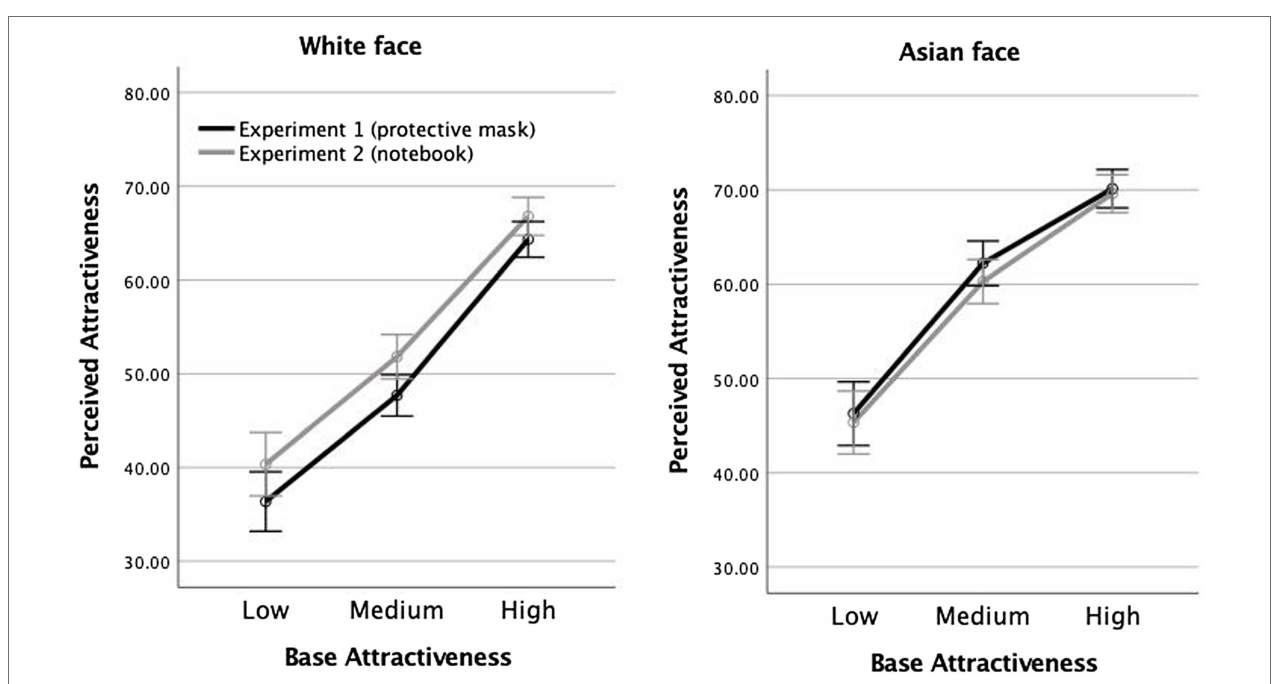
FIGURE 5 | Perceived attractiveness for faces without any occlusion in Experiment 1 (black line) and Experiment 2 (gray line). Error bars represent +/ − 1 standard